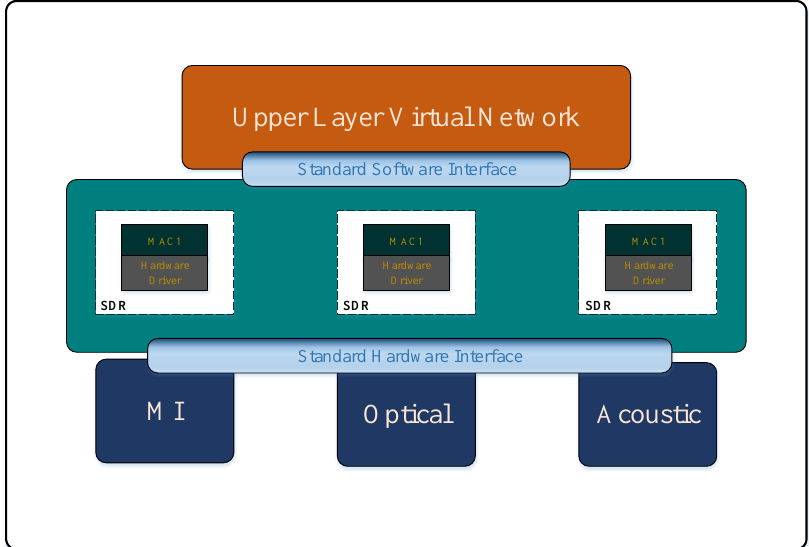
Figure 2. Implement of multi-modal access interconnection in MMNET.